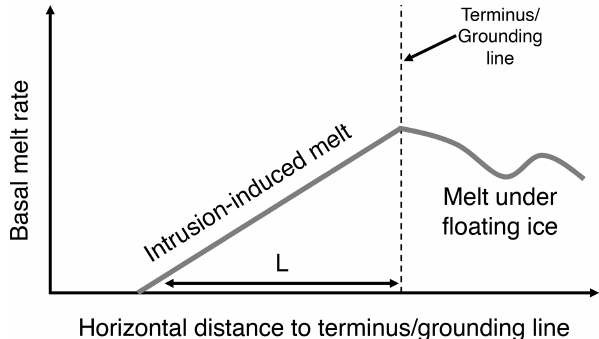
Figure 5. Illustrative schematic of a parameterization for basal melt under grounded ice caused by seawater